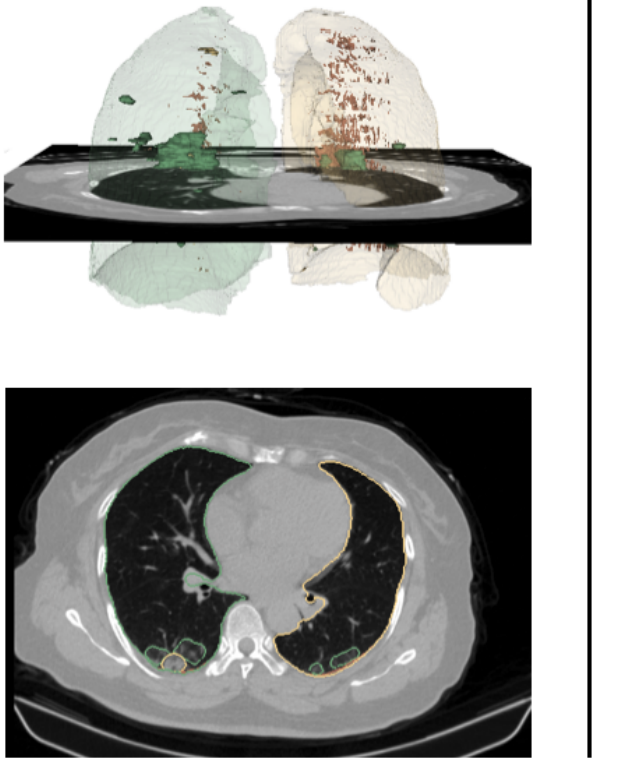
Figure 1. Representative chest computed tomography scans and the lung and lesion models of (A) a mild COVID-19 case and (B) a severe COVID-19